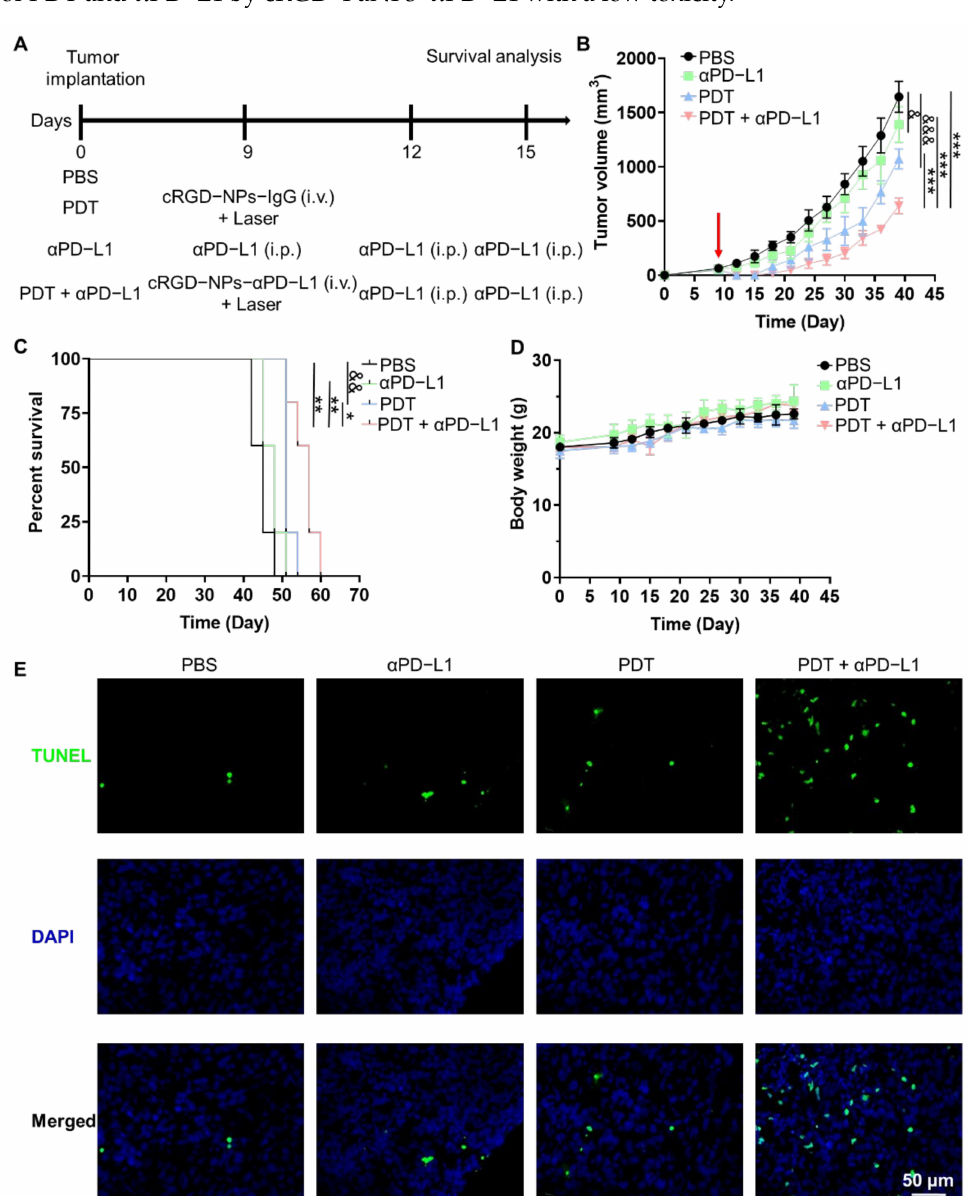
Figure 5. The antitumor effect of the combinatorial therapy of the 4T1–bearing mice. ( A ) Schematic illustration of the regimens for different treatments. ( B ) Average tumor growth curves over time. Arrow, treatment started. ( C ) Survival of the 4T1–bearing mice after the treatment. ( D ) Body weight of mice following the treatment. ( E ) Fluorescence micrographs of tumor stained with TUNEL following different treatment. Data are presented as mean ± SD ( n = 5). * p < 0.05, ** p < 0.01 and *** p < 0.001 compared with the PDT + α PD–L1 group. & p < 0.05, && p < 0.01 and &&& p < 0.001 compared with the PBS